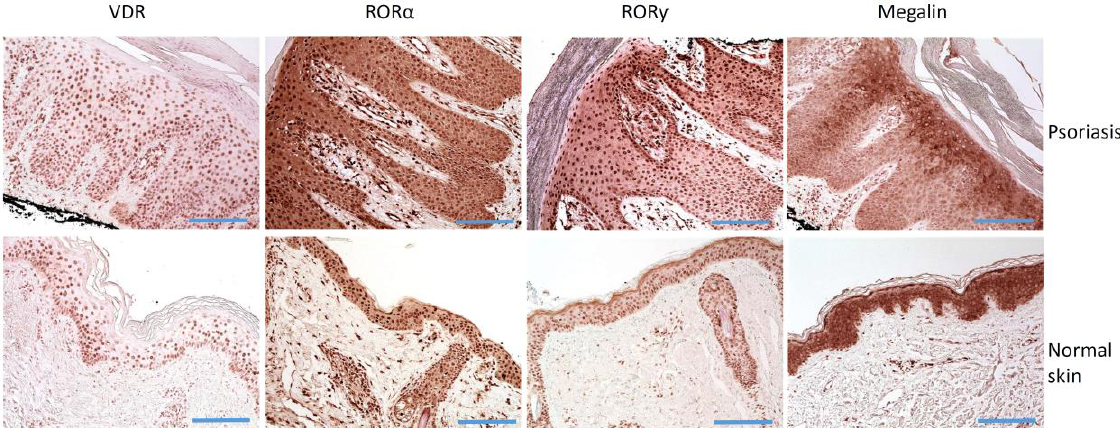
Figure 2. Immunostaining of VDR, RORα and RORγ, and LRP2/megalin in psoriasis and normal skin. Histology of lesional skin shows skin with regular psoriasiform epidermal hyperplasia, prominent dilated vessels with an edematous dermal papillae, mounds of parakeratosis containing neutrophils, and a superficial perivascular lymphocytic infiltrate. Scale bars = 100 μm. Hosomi et al. [123] firstly reported the stimulatory effects of 1,25(OH) 2 D 3 on keratino-